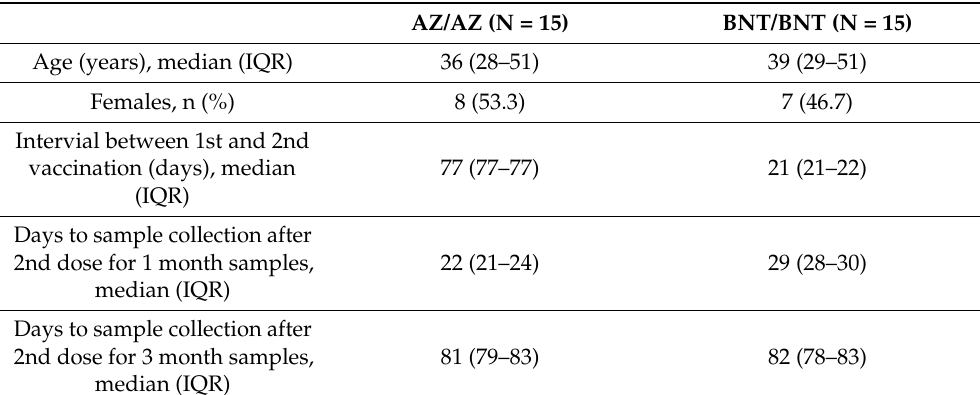
Table A1. Characteristics of thirty vaccinated